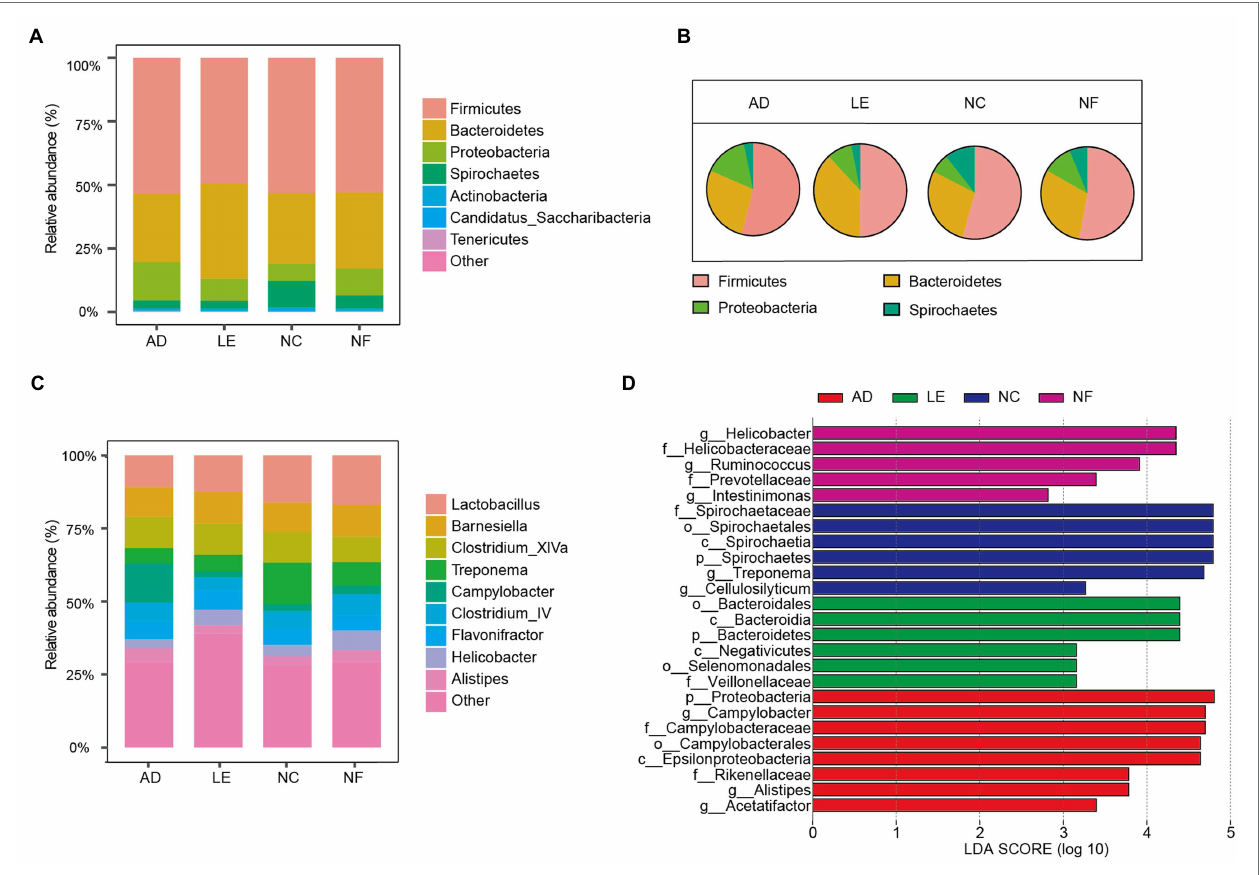
FIGURE 2 | Variation of gut microbial composition between four rodent species. (A) Abundance represented as the proportions of ASVs classified at the phylum rank. (B) Pie chart of four main phyla in four rodent species. (C) Abundance represented as the proportions of ASVs classified at the genus rank. (D) Differential bacterial taxa selected by linear discriminant analysis (LDA) Effect Size (LEfSe) analysis with LDA score >2 in gut microbiota community of four